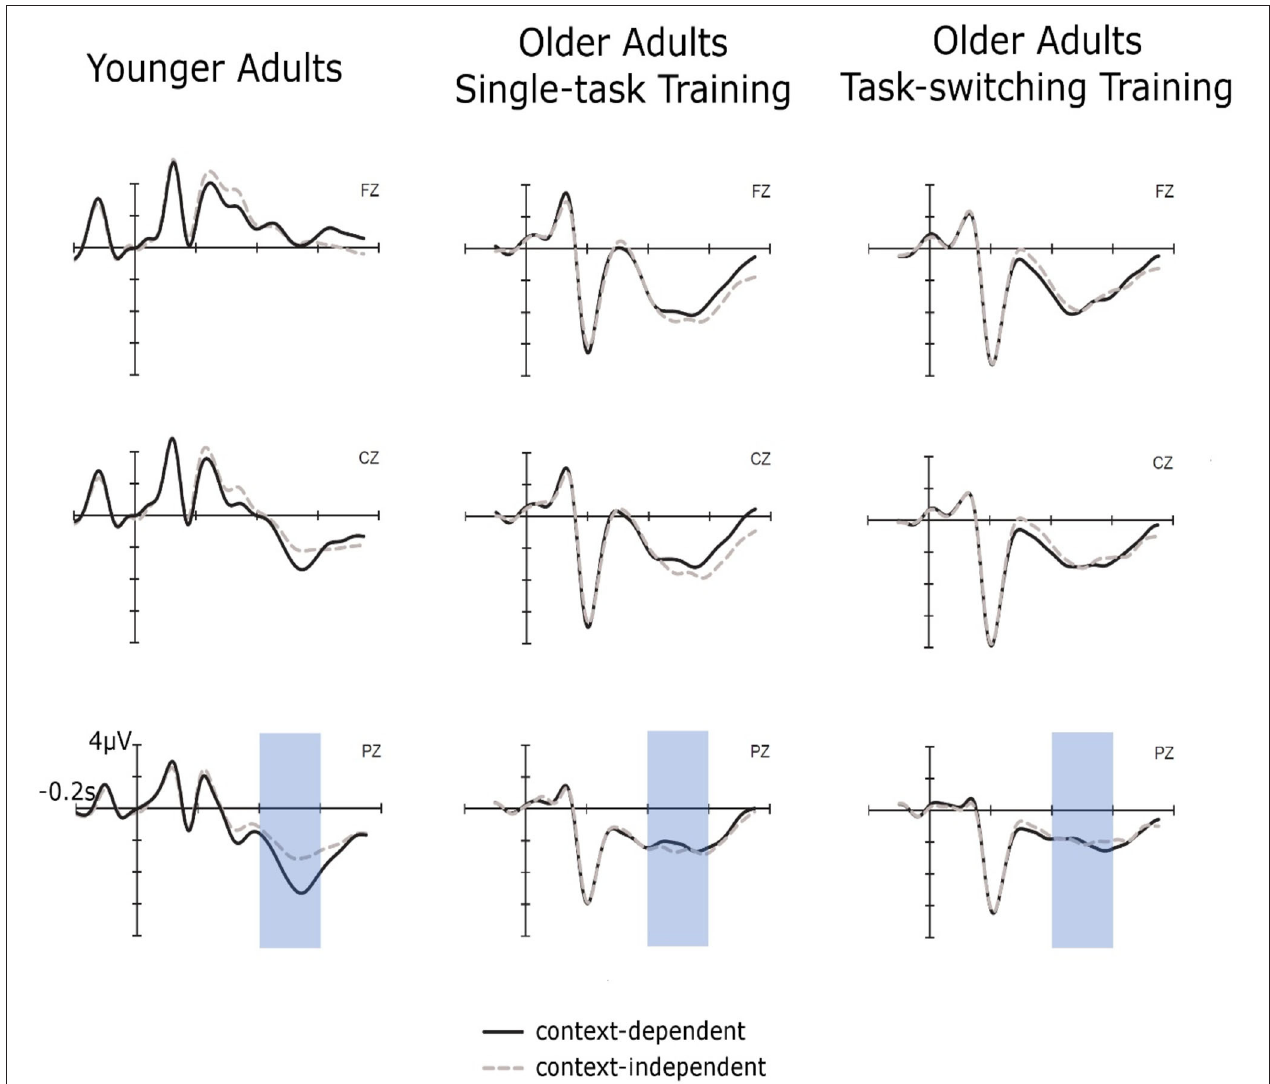
FIGURE 7 | Cue-locked ERPs for context-dependent and context-independent trials at posttest for younger adults, older adults in the single-task training group, and older adults in the task-switching training group displayed at electrodes Fz, Cz, and